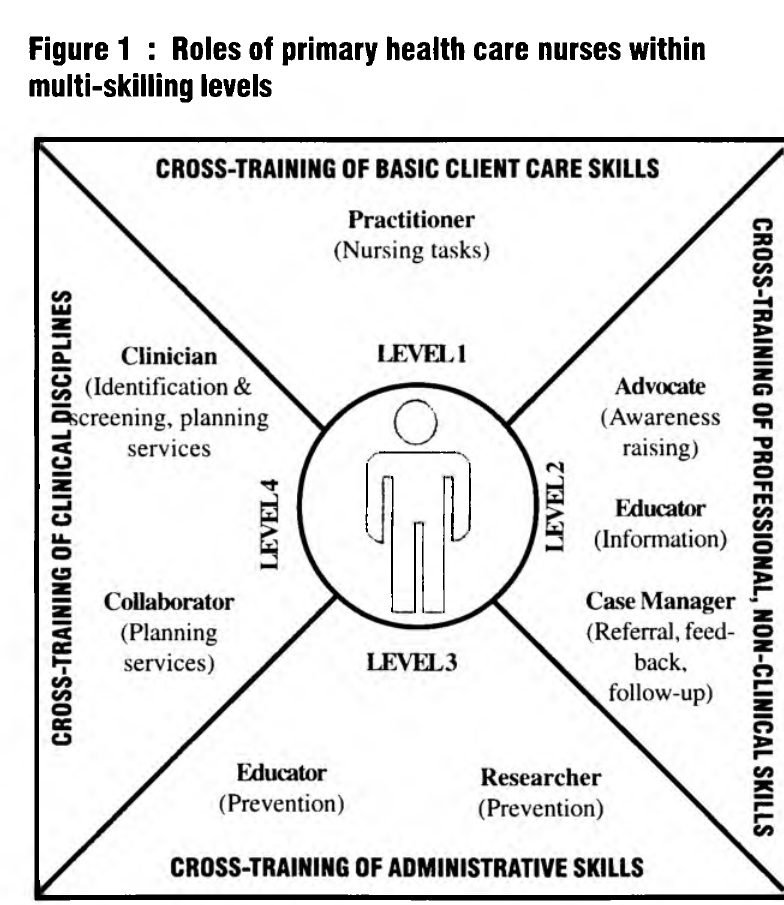
Figure 1 : Roles of primary health care nurses within multi-skilling